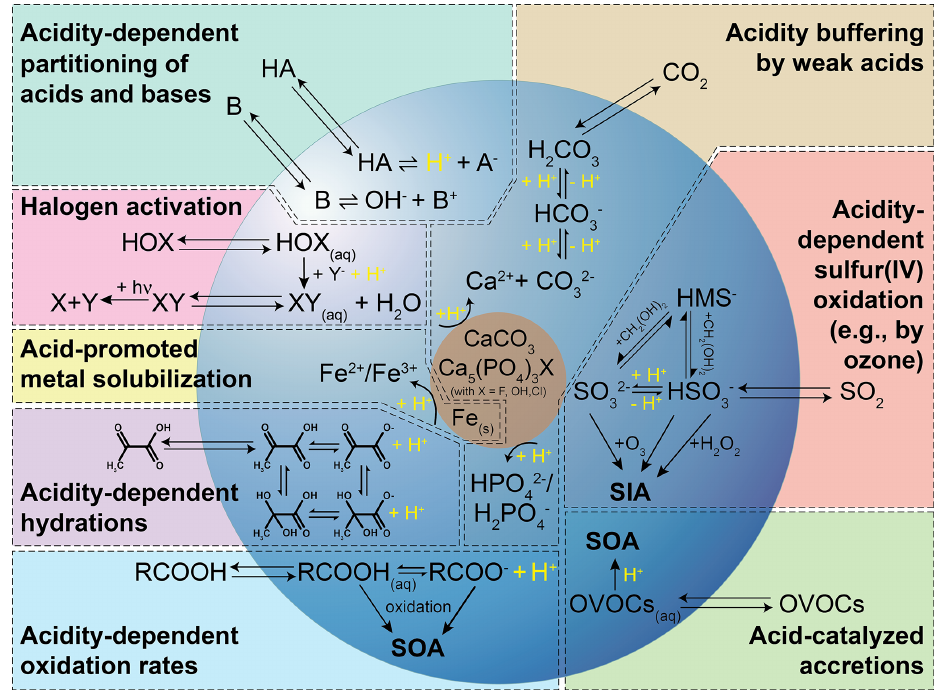
Figure 1. Schematic of chemical processes influenced by and affecting acidity in tropospheric aerosols.